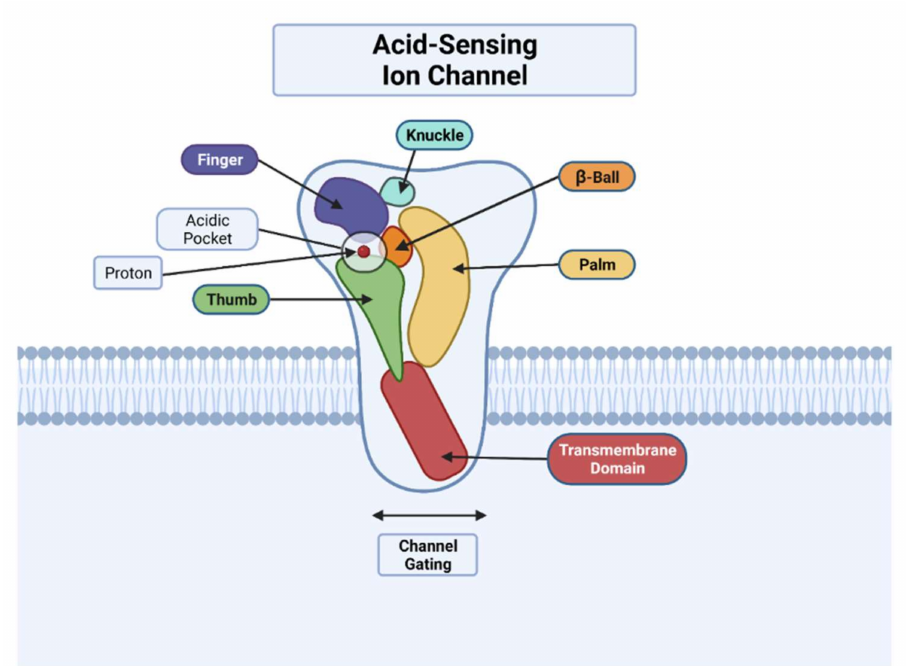
Figure 1. “Closed-fist” model of ASICs. An ASIC subunit has a “closed-fist” morphology, consisting of five protein domains, and each is visualized above. Also depicted is the acidic pocket located between the finger and thumb domains of one ASIC subunit and the palm domain of another subunit. Proton binding to the acidic pocket activates ASICs and results in sodium ion permeation. In addition to the sodium permeability of ASICs, certain ASIC subunits such as homomeric ASIC1a also have calcium permeability. Adapted from “Transporters” by BioRender.com (2021).